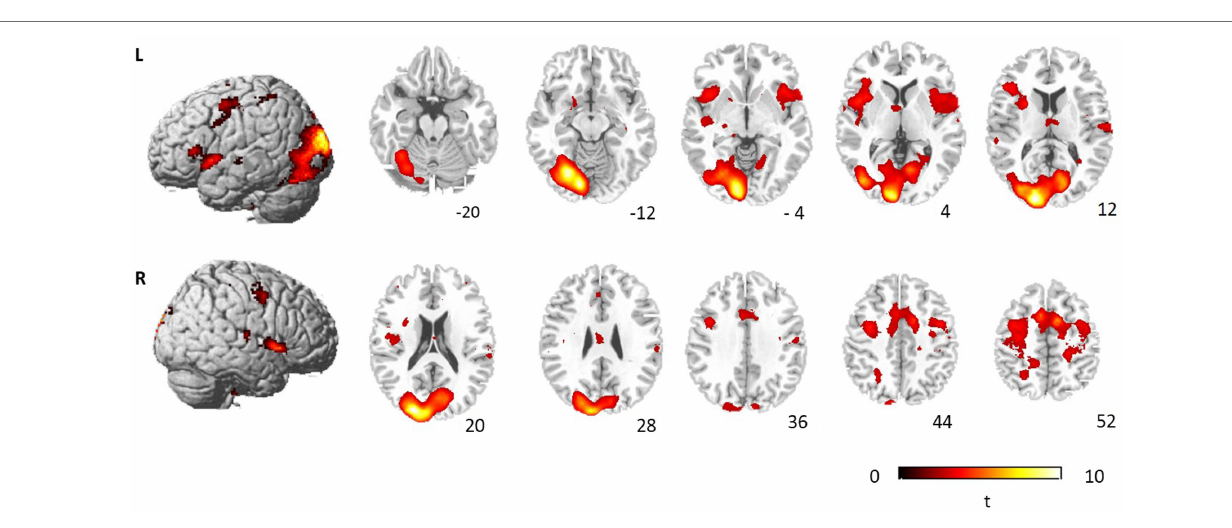
FIGURE 3 | Brain regions showing significant activation during incongruent judgment. The significant threshold is p < 0.05 FDR